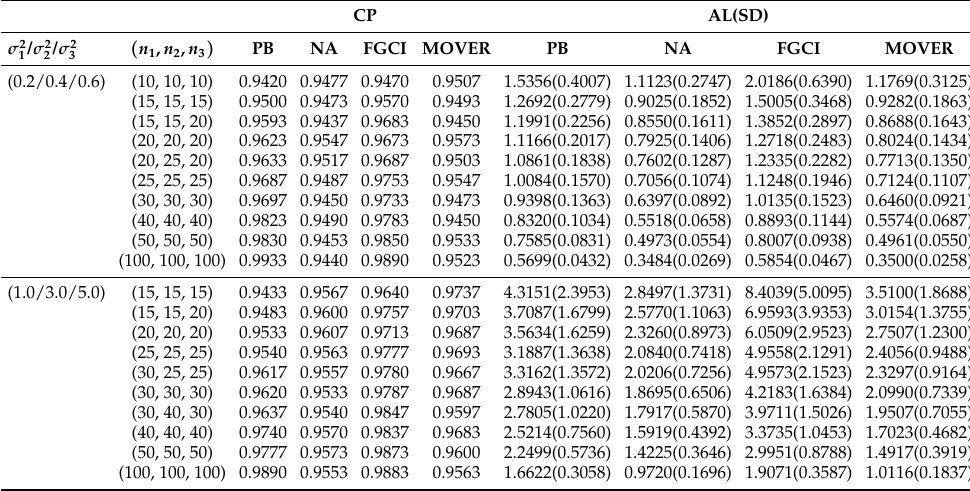
Table 4. CP and AL of 95% SCIs for different methods under ( µ 1 , µ 2 , µ 3 ) = ( 0,0,0 ) . CP AL(SD) σ 2 1 / σ 2 2 / σ 2